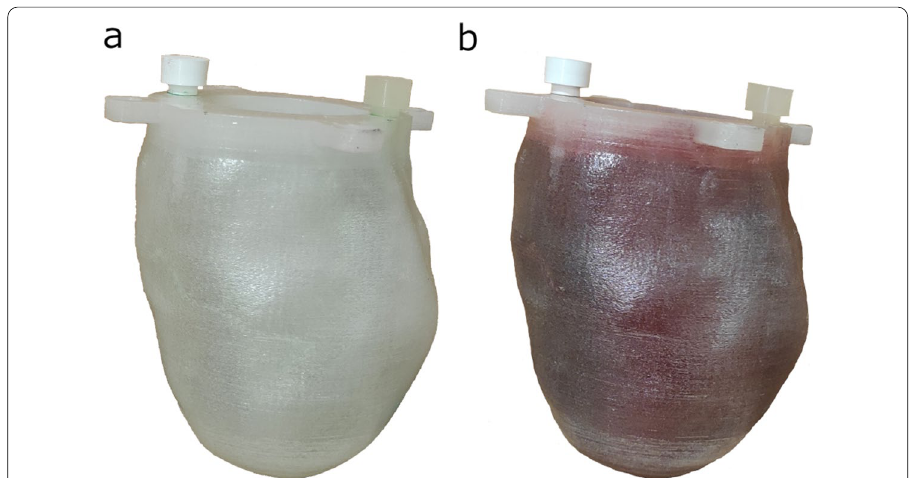
Fig. 3 Photographs of the real 3D printed LVm healthy phantom before ( a ) and after ( b ) a red food-dye